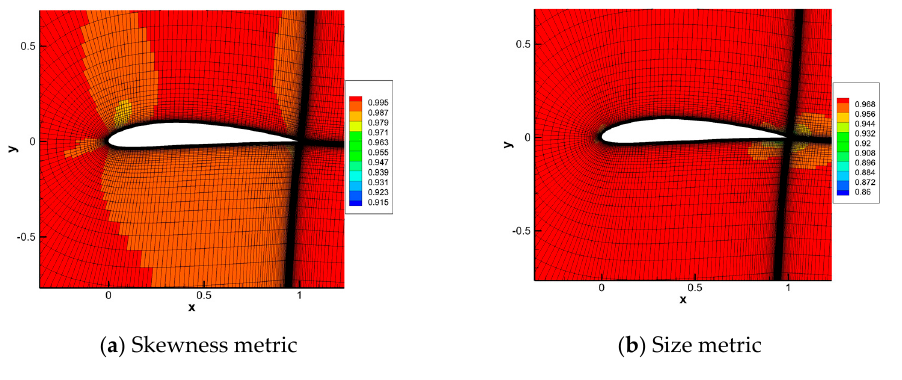
Figure 17. Mesh quality near the airfoil. Table 6. Comparison between mapping-based metric and mesh-based metrics.